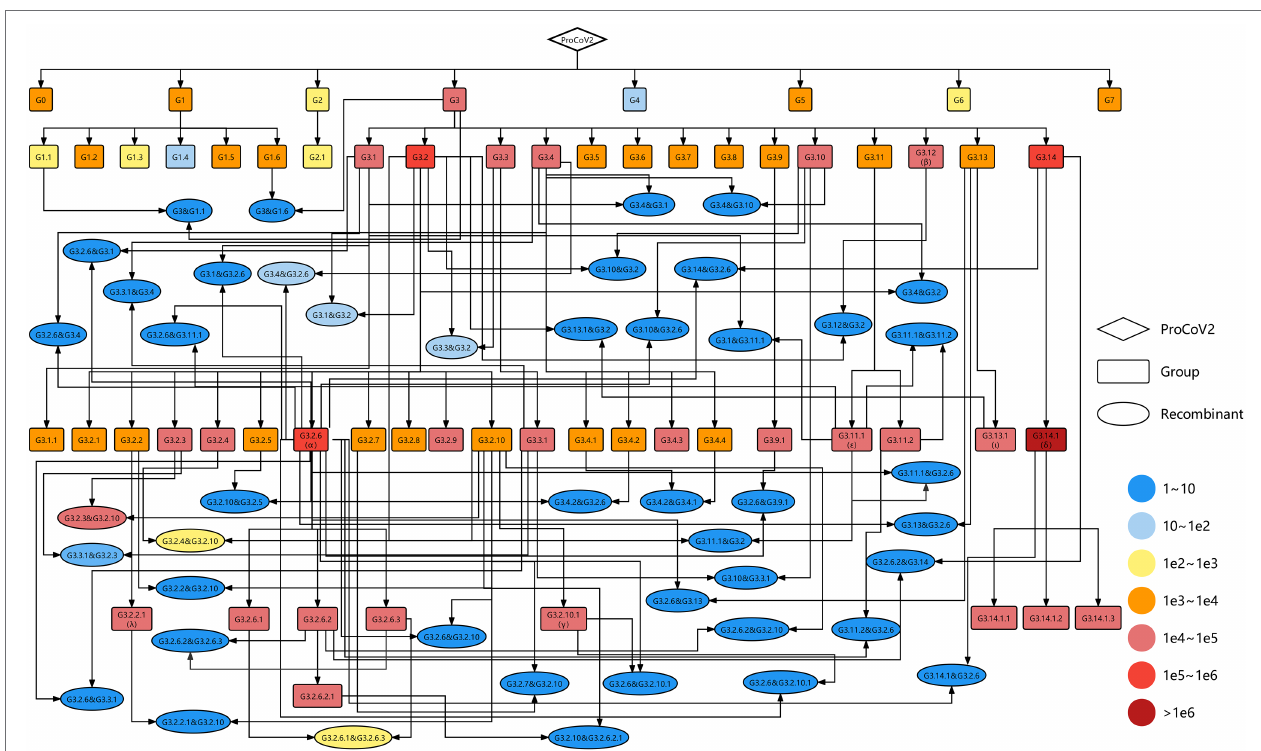
FIGURE 2 | Genetic map including all identified SARS-CoV-2 variants. The diamond ， rectangles, and ellipses represent the origin of SARS-CoV-2 (ProCoV), 58 groups and 46 recombination types, respectively. The recombination types were named parent 1 and parent 2, where the former is the parent of the non- recombinant region and the latter is the parent of the recombinant region. The color corresponds to the number of samples in each variant. The black lines with arrows indicate the evolutionary